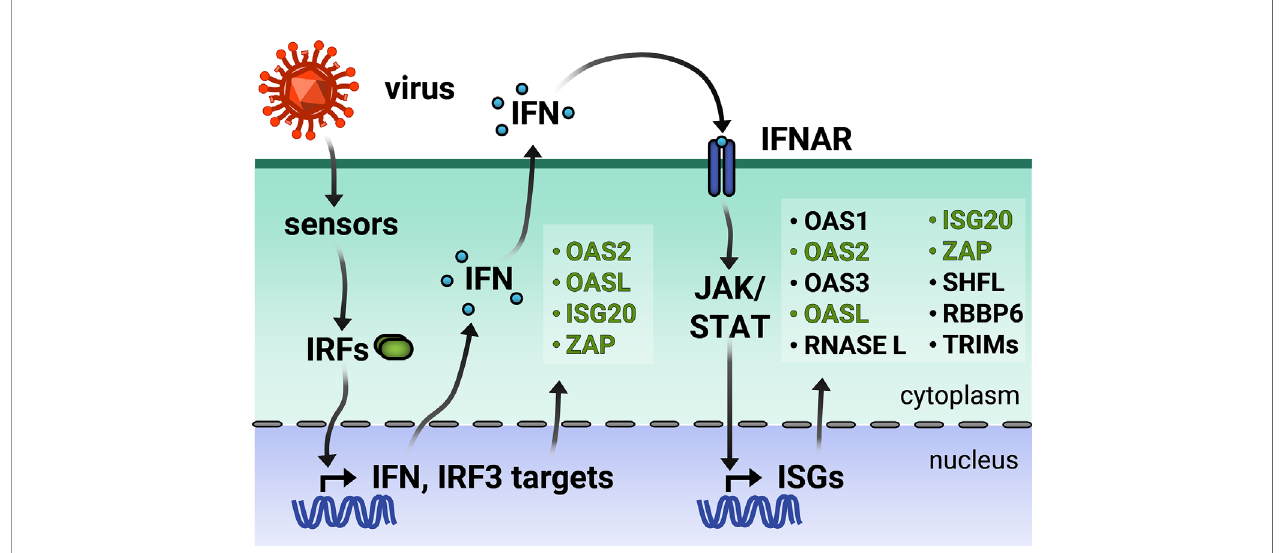
FIGURE 1 | Viral infection triggers the type I interferon (IFN) response. Virus entry triggers cellular pathogen sensors, which induce production of IFN and IFN regulatory factor 3 (IRF)-dependent genes. Type I IFN is secreted and binds to IFN- a receptor on the same and neighboring cells, activating production of a wider array of IFN-stimulated genes (ISGs). IRF3-dependent ISGs are colored in green. TRIMs is not inclusive of the entire TRIM family, but only those inducible by